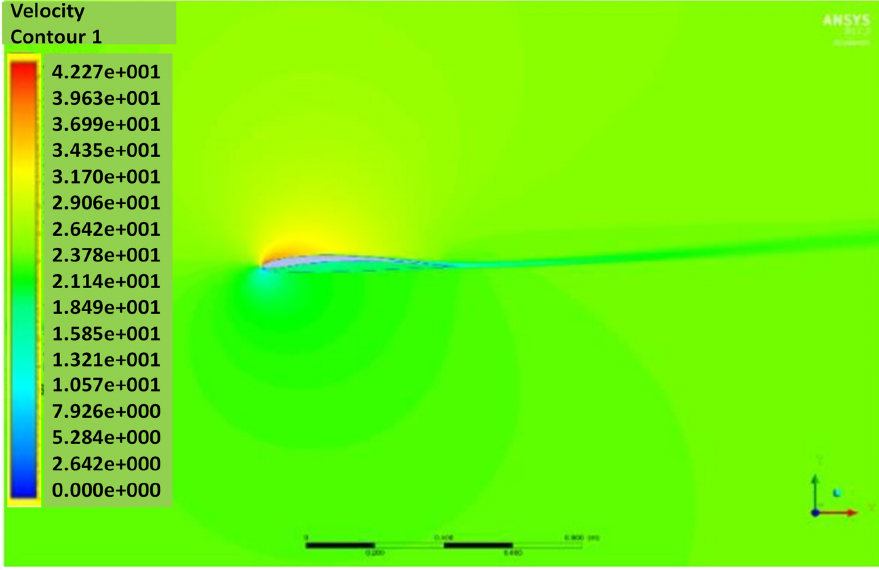
Figure 21. Pressure contour of the NACA2410 to 8410 transition at AoA 5°.